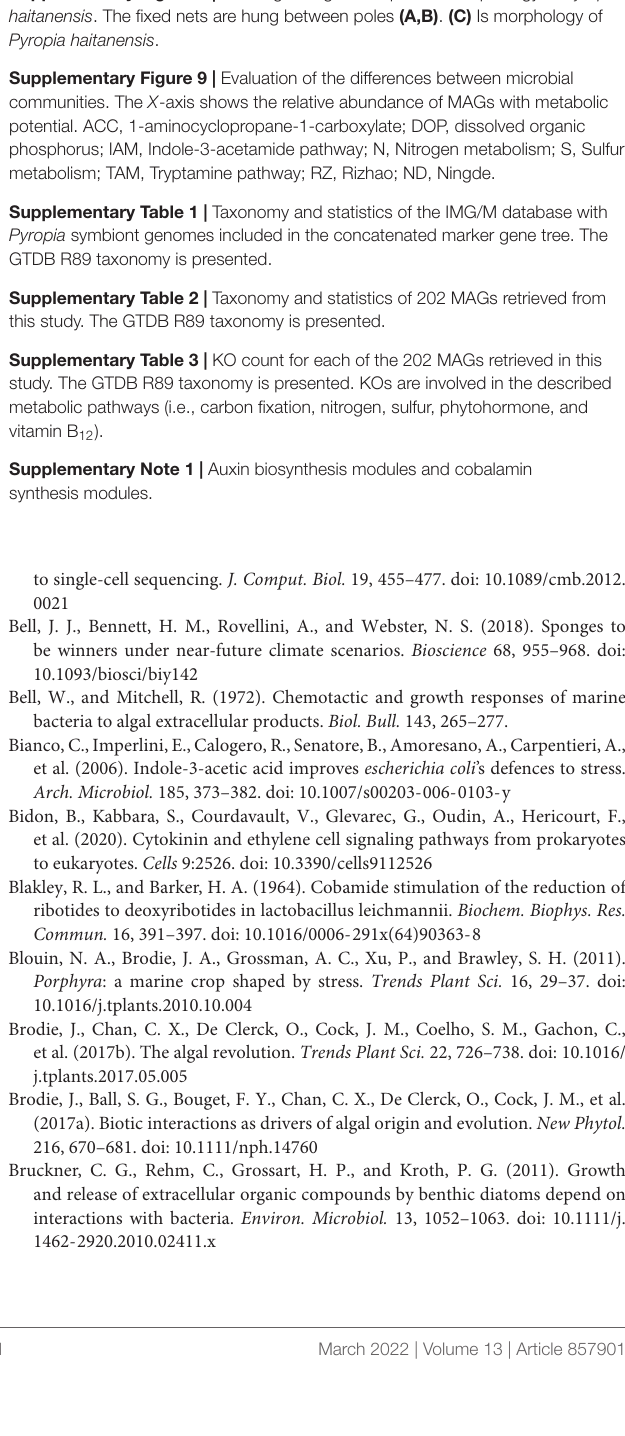
Supplementary Figure 8 | The ongrowing technique and morphology of Pyropia haitanensis . The fixed nets are hung between poles (A,B) . (C) Is morphology of Pyropia haitanensis . Supplementary Figure 9 | Evaluation of the differences between microbial communities. The X -axis shows the relative abundance of MAGs with metabolic potential. ACC, 1-aminocyclopropane-1-carboxylate; DOP, dissolved organic phosphorus; IAM, Indole-3-acetamide pathway; N, Nitrogen metabolism; S, Sulfur